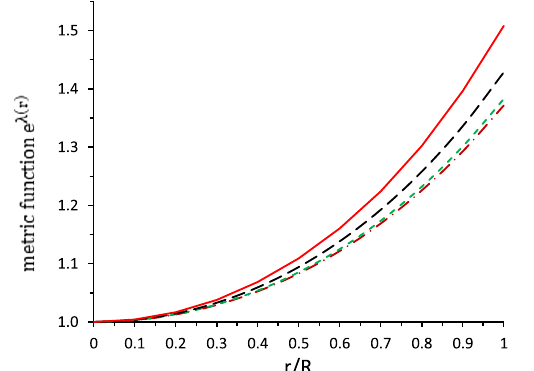
Fig. 2 The trend of metric function e λ( r ) versus radial coordinate r / R . We have described same set of values for different curves as motioned in Fig.